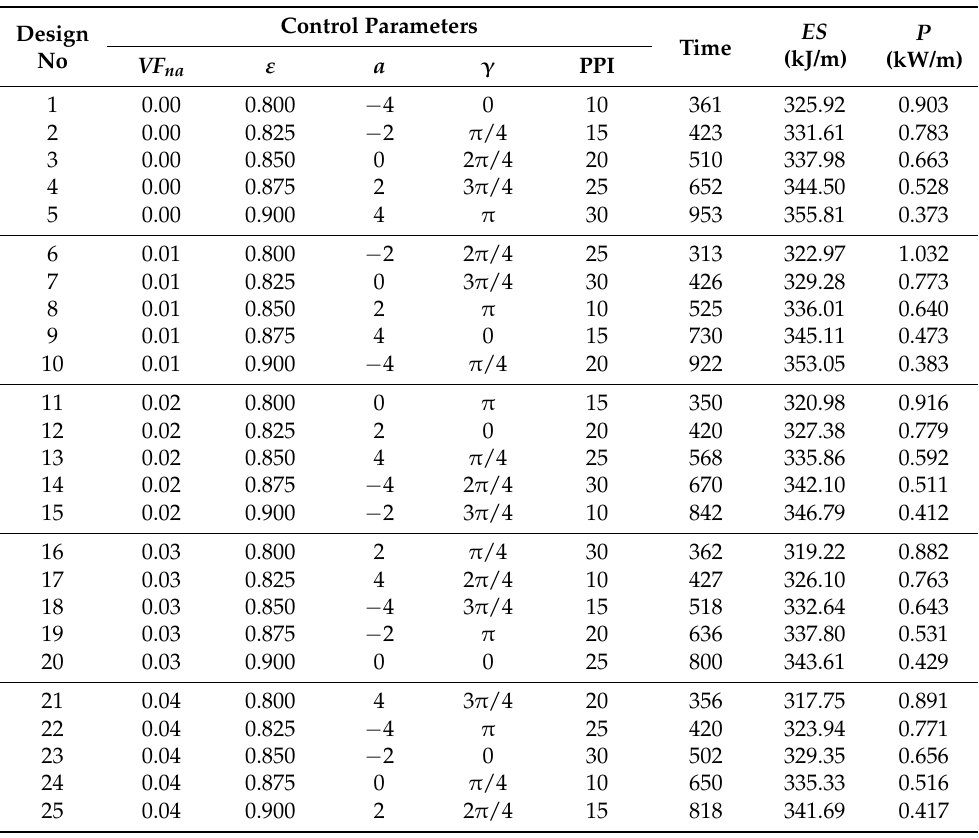
Table 2. L25 orthogonal table corresponding to range and levels of control parameters for y -variation when MVF =